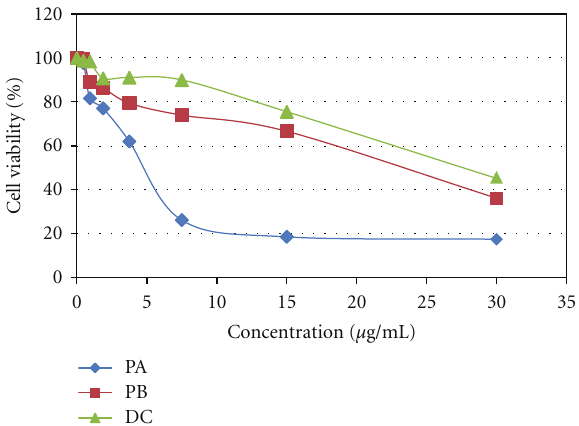
Figure 4: Percentage viability of MCF7 cells treated with di ff erent concentration of pyranocycloartobiloxanthone A ( 1 ) (PA), dihy- droartoindonesianin C ( 2 ) (DC), and pyranocycloartobiloxanthone B ( 3 ) (PB) measured after 72 hours using MTT assay.